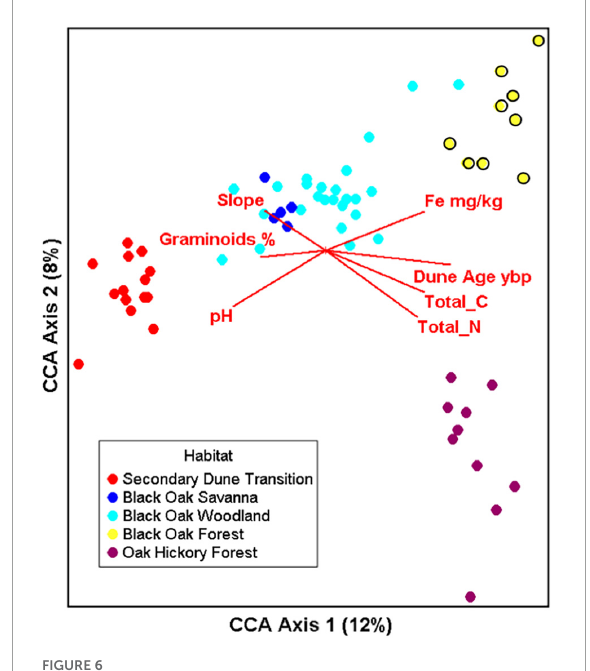
FIGURE6 Canonical correspondence analysis (CCA) illustrating the relationship of bacterial genera (log transformed counts) to dune age, slope, soil chemical factors (pH, CEC, OM (% organic matter), concentrations of Fe, K, Mn, P, B ppm), % bare ground, litter cover, and graminoids. CCA1 and 2 explain 12.0 and 8.0% of the total constrained variation, respectively. Number of samples n = 64, overall p < 0.001 with 999 permutations. All variable tested in the model are listed in Supplementary Table 5